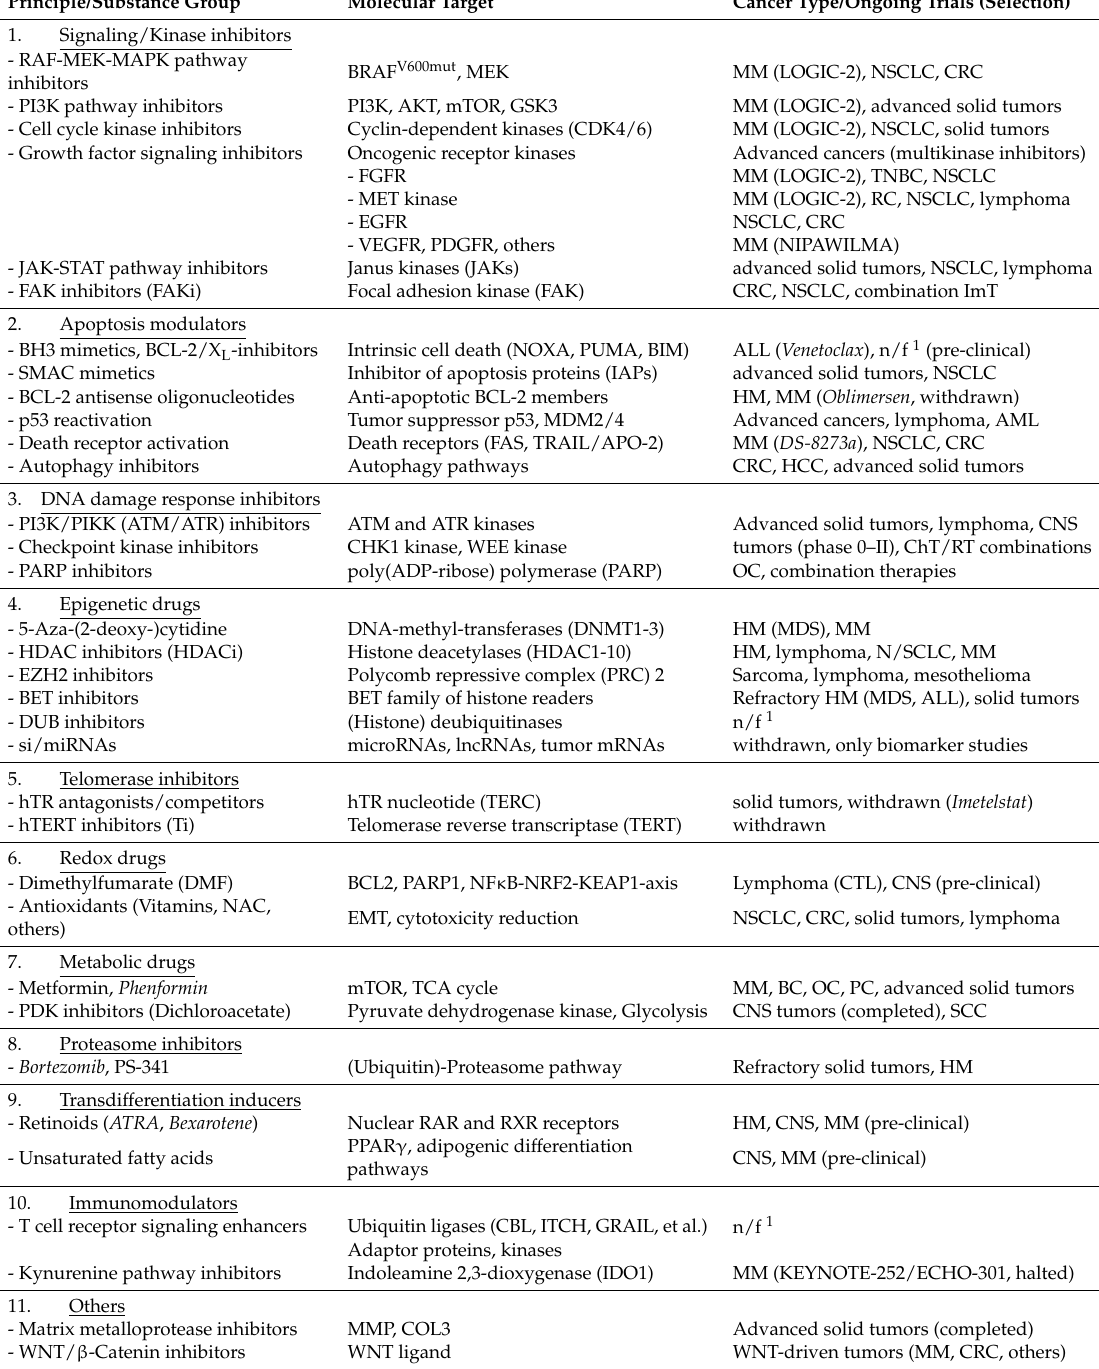
Table 1. Targeted tumor therapy strategies, selected agents, and their molecular targets in selected ongoing clinical